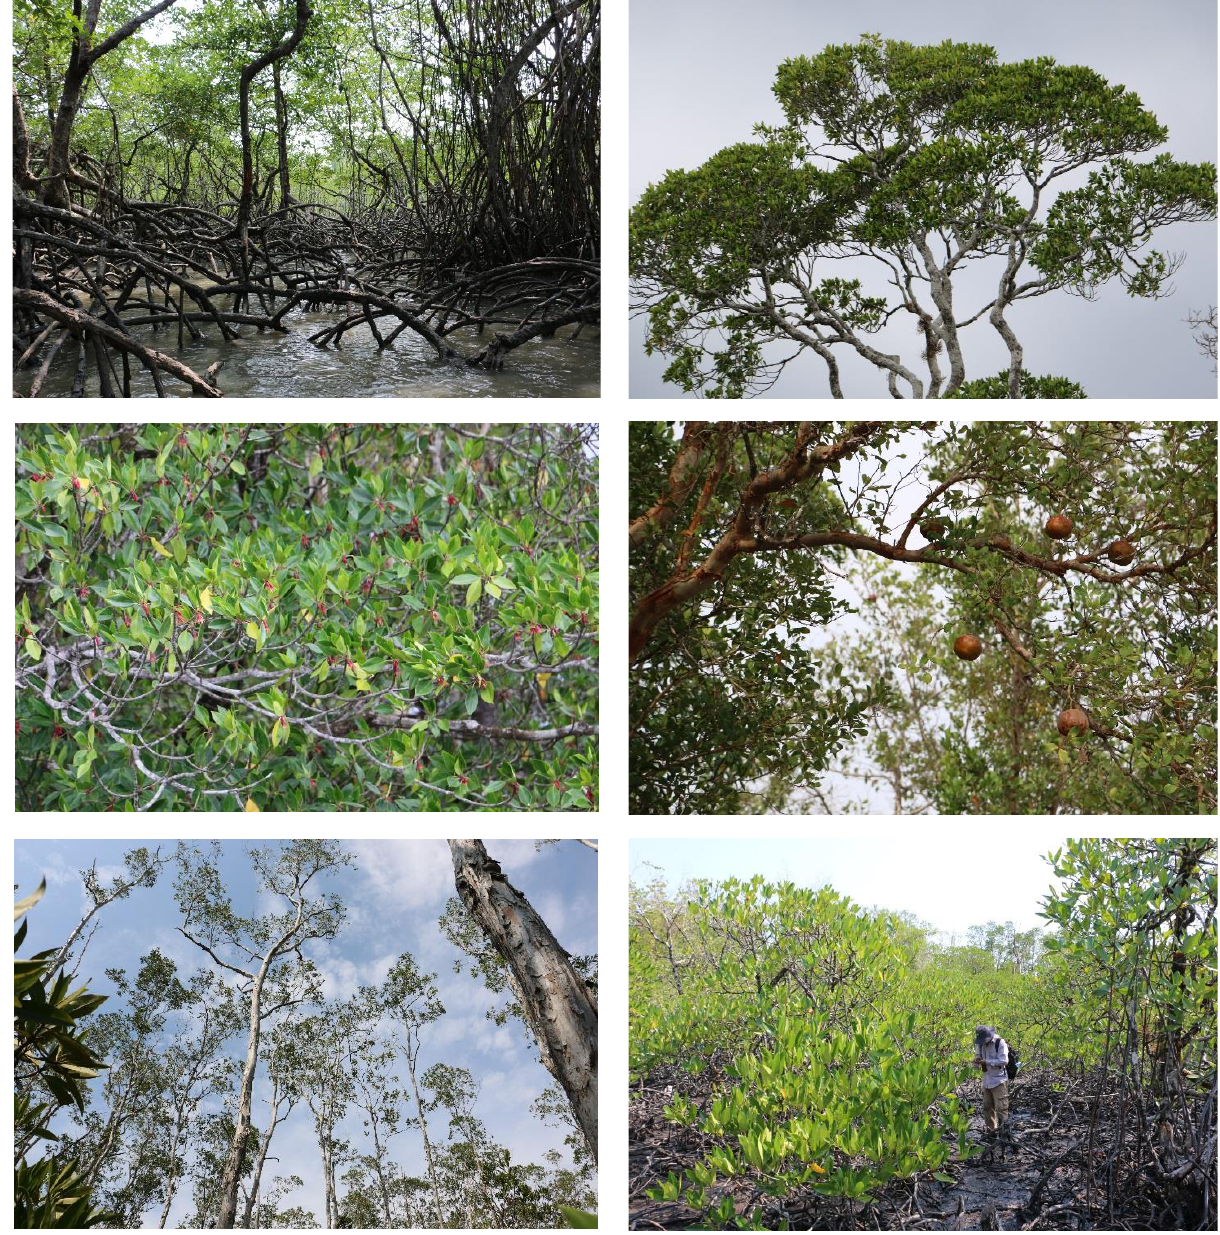
Figure 4. Some of the mangrove species mentioned in the text: Rhizophora apiculata at the fringing area (top left); three common tree species found in study area, namely Bruguiera sexangula (top right), Bruguiera gymnorrhiza (middle left) and Xylocarpus granatum (middle right); a Melaleuca cajuputi stand (bottom left); and the dwarf form of Rhizophora apiculata (bottom right).